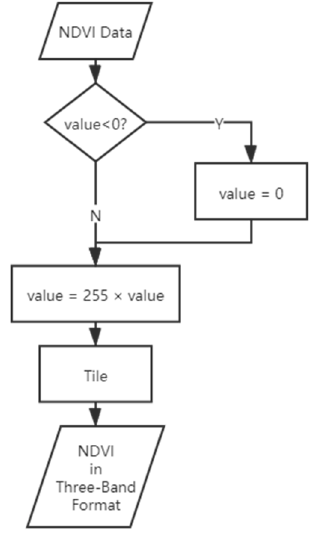
Figure 3. Workflow of the NDVI image data pre-processing.